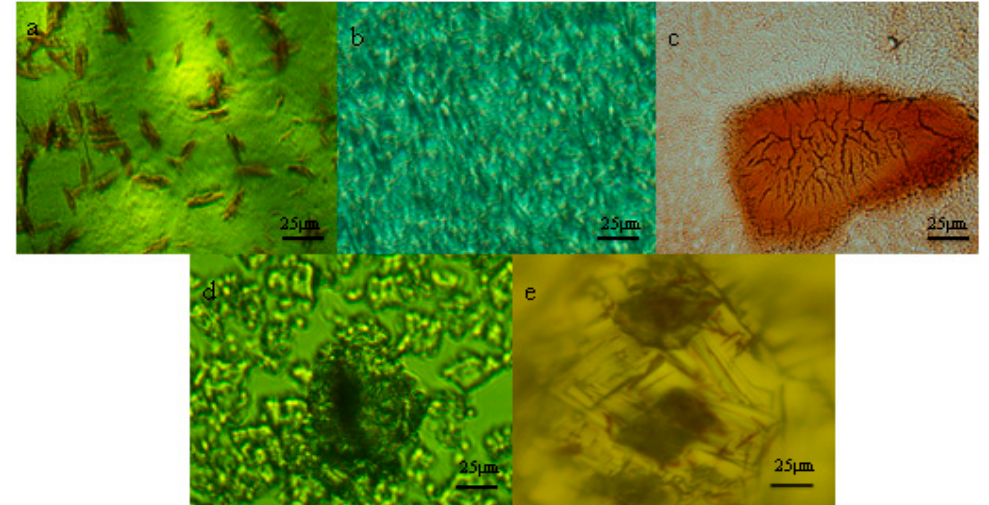
Figure 2. Micrograph of lycopene ( a ), β -CD ( b ), their physical mixtures ( c ) and inclusion complexes (aqueous solution ( d ), crystal structure ( e )).